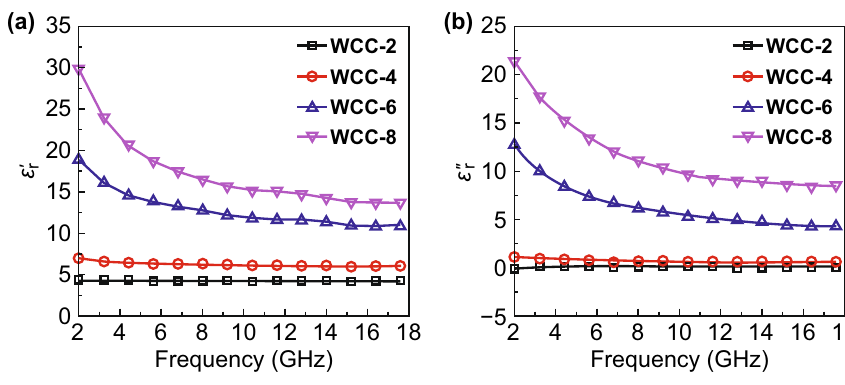
Fig. 5 a Real parts and b imaginary parts of relative complex permittivity of different tungsten carbide/carbon